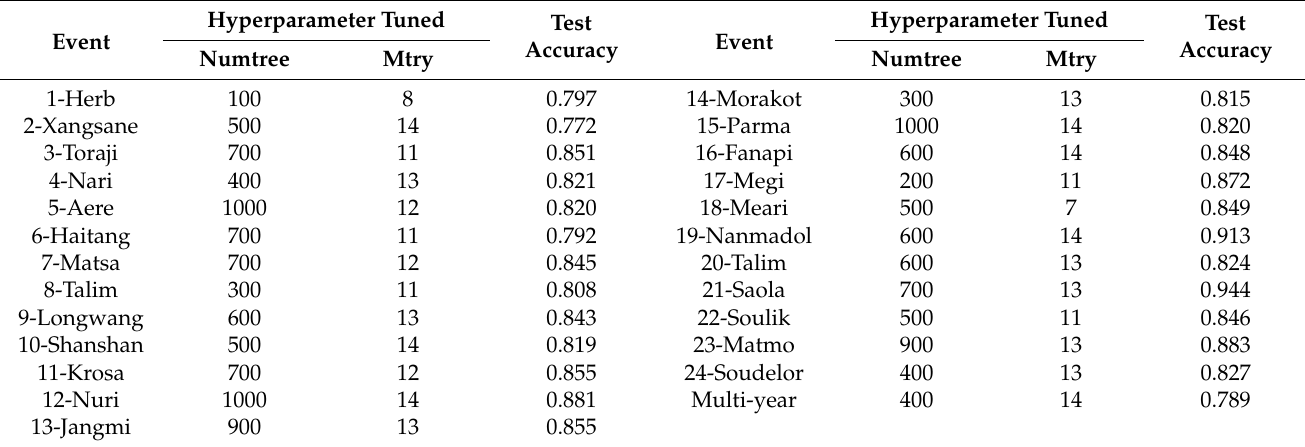
Table 5. The tuned hyperparameters and model performances for RF models.